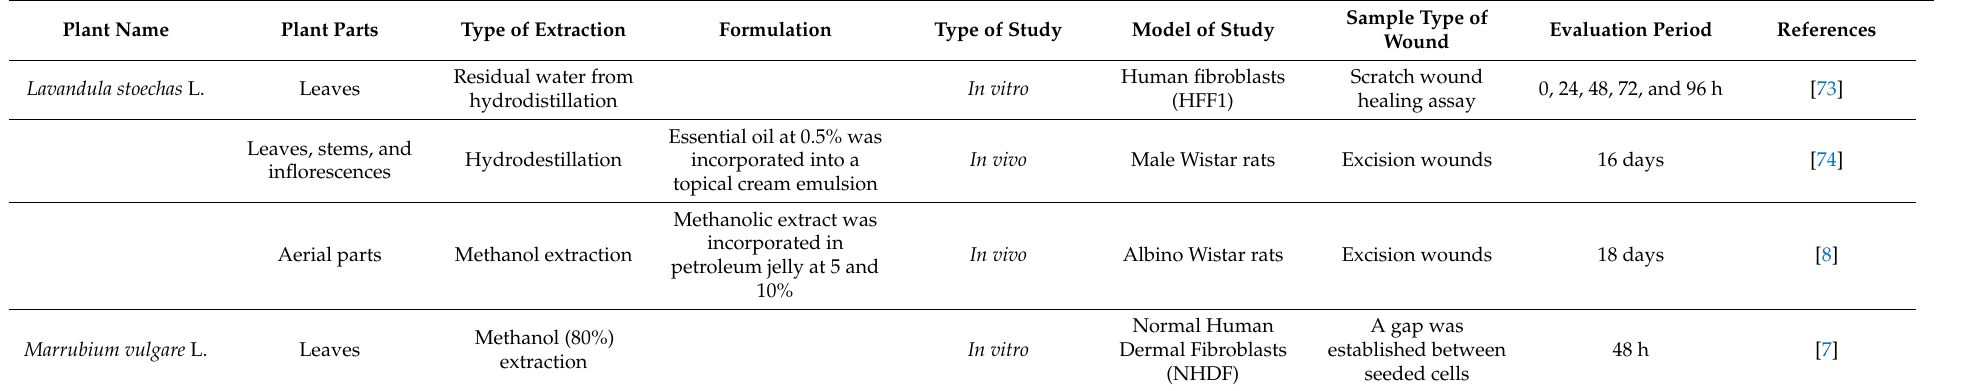
Table 3. Key findings of in vitro and in vivo studies using Iberian Lamiaceae species with wound healing scientific